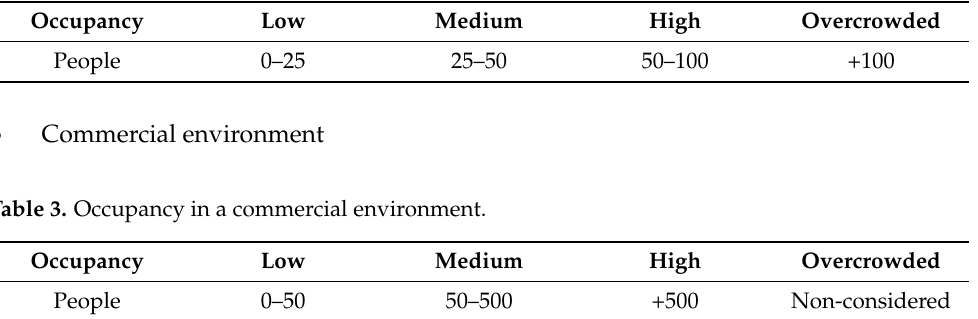
Table 2. Occupancy in an administrative environment.